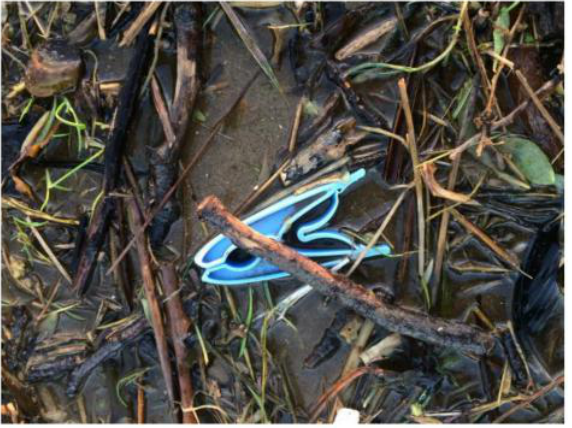
Figure 7. Clothes peg on Hoylake